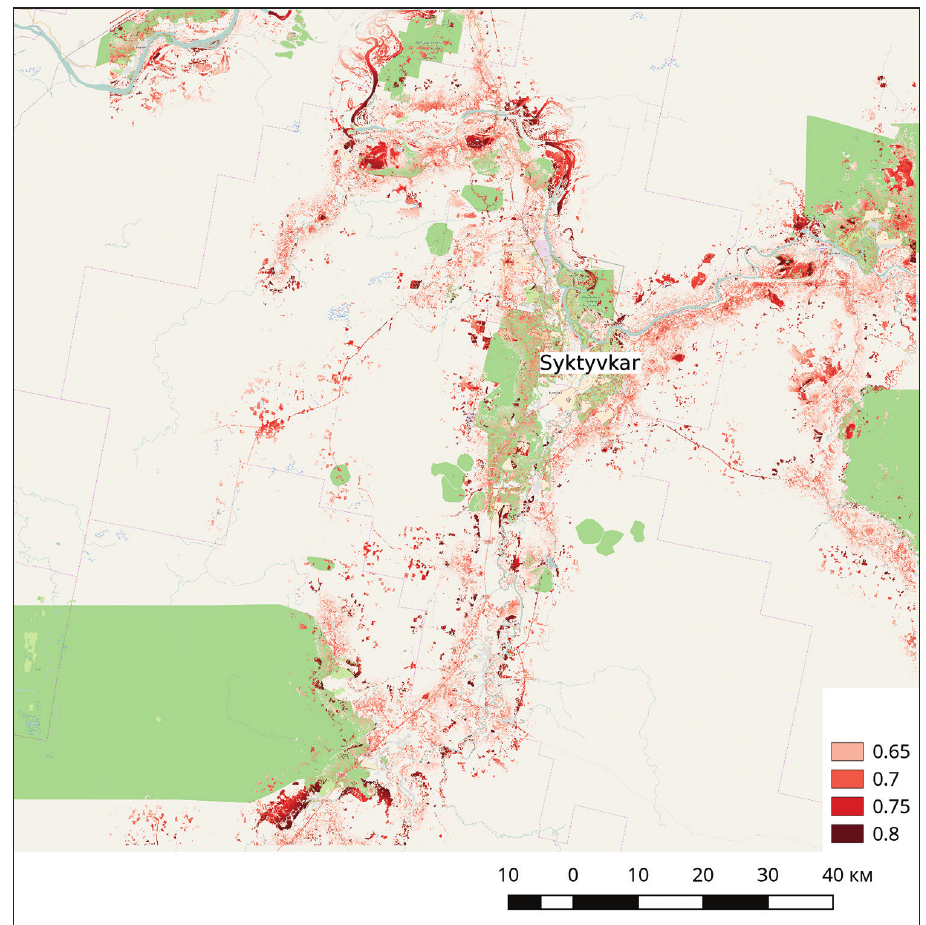
Figure 2. The prediction map of Heracleum sosnowskyi habitats prepared with the species distribution model based on vegetation cover map, nearest road proximity map, proximity map to the borders of agri- cultural areas. The colour scale shows the probability H. sosnowskyi